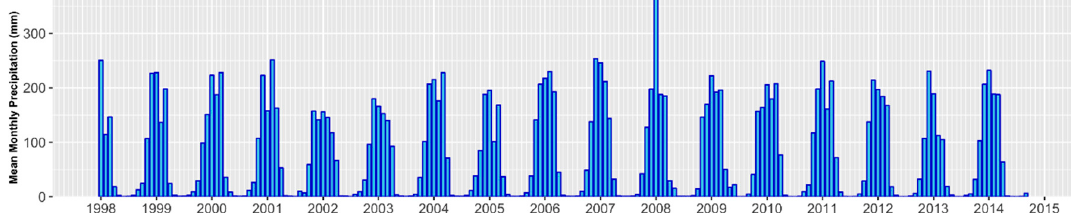
Figure 2. Mean monthly precipitation in the Upper Zambezi Sub basin calculated from TRMM 3B43 data for the period 1998–2014.